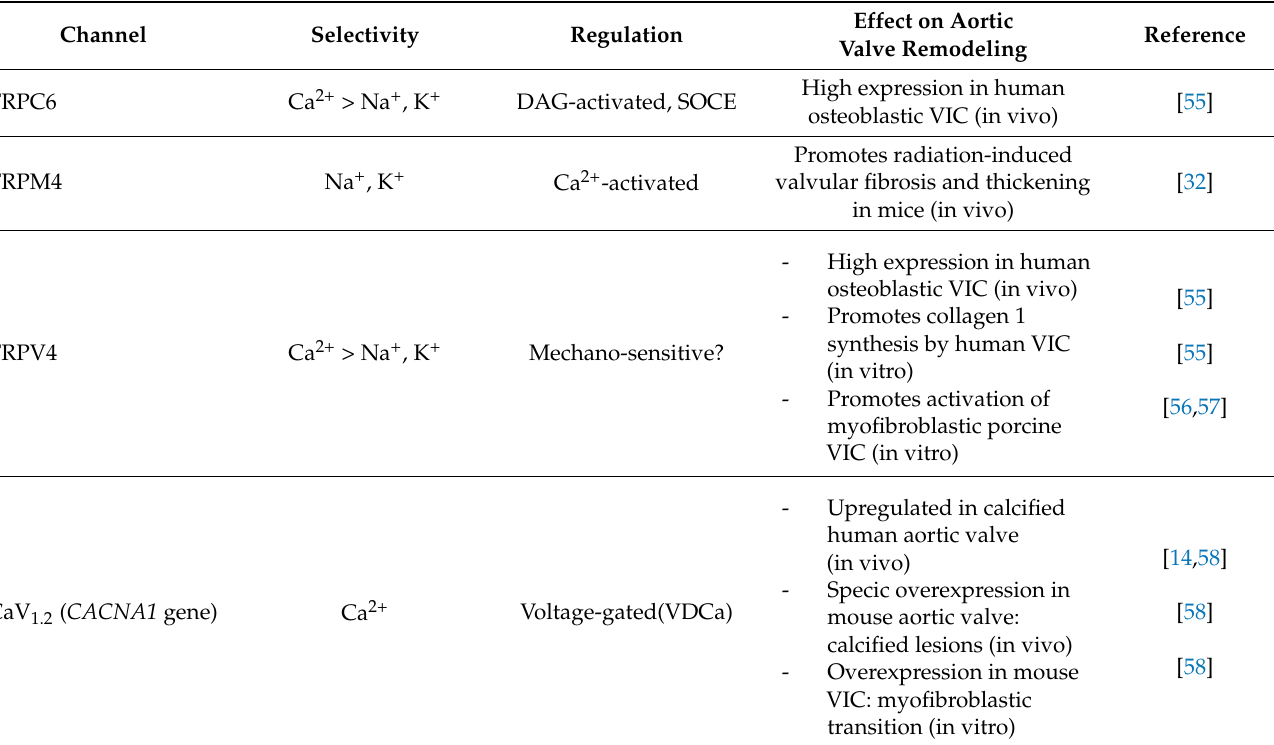
Table 2. Ion channels involved in aortic valve remodeling. DAG: Diacylglycerol; SOCE: